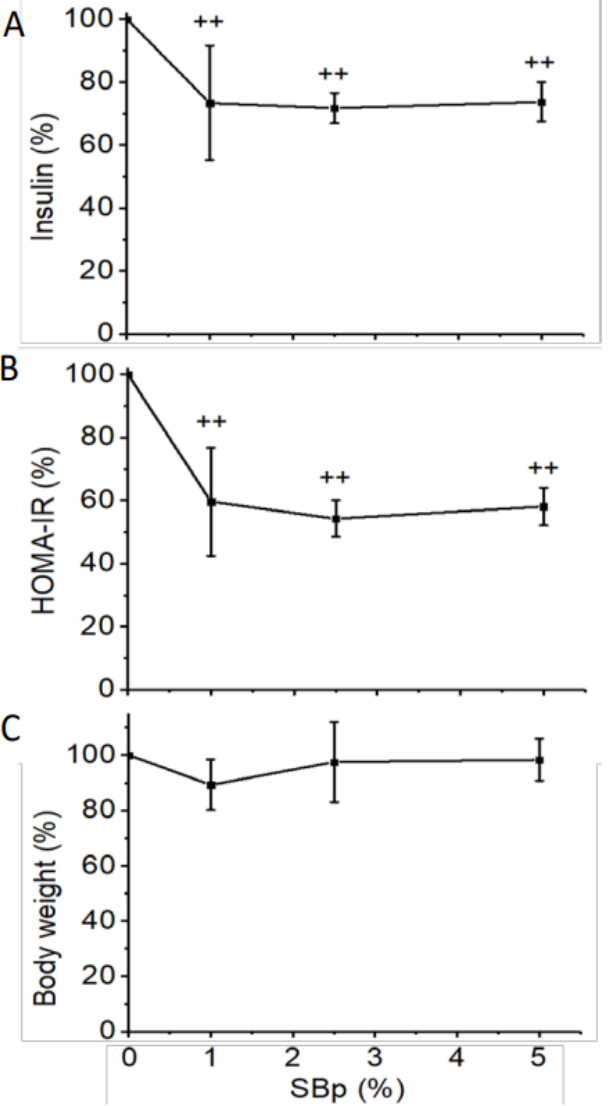
Figure 2. Effects of HFHS diets supplemented with 0–5% SBp on insulin, insulin resistance and body weight in mice. The experimental regimen was described in the legend of Figure 1. Homeostatic model assessment of insulin resistance (HOMA-IR) measurements were analyzed from the levels of insulin and glucose in fasting plasma collected at the end of the intervention. Body weights were measured at the last weeks of the intervention. Relative changes in insulin ( A ), HOMA-IR ( B ) or body weights ( C ) vs. HFHS group were expressed in mean ± SD % ( n = 8/group). ++: p < 0.01 vs. HFHS